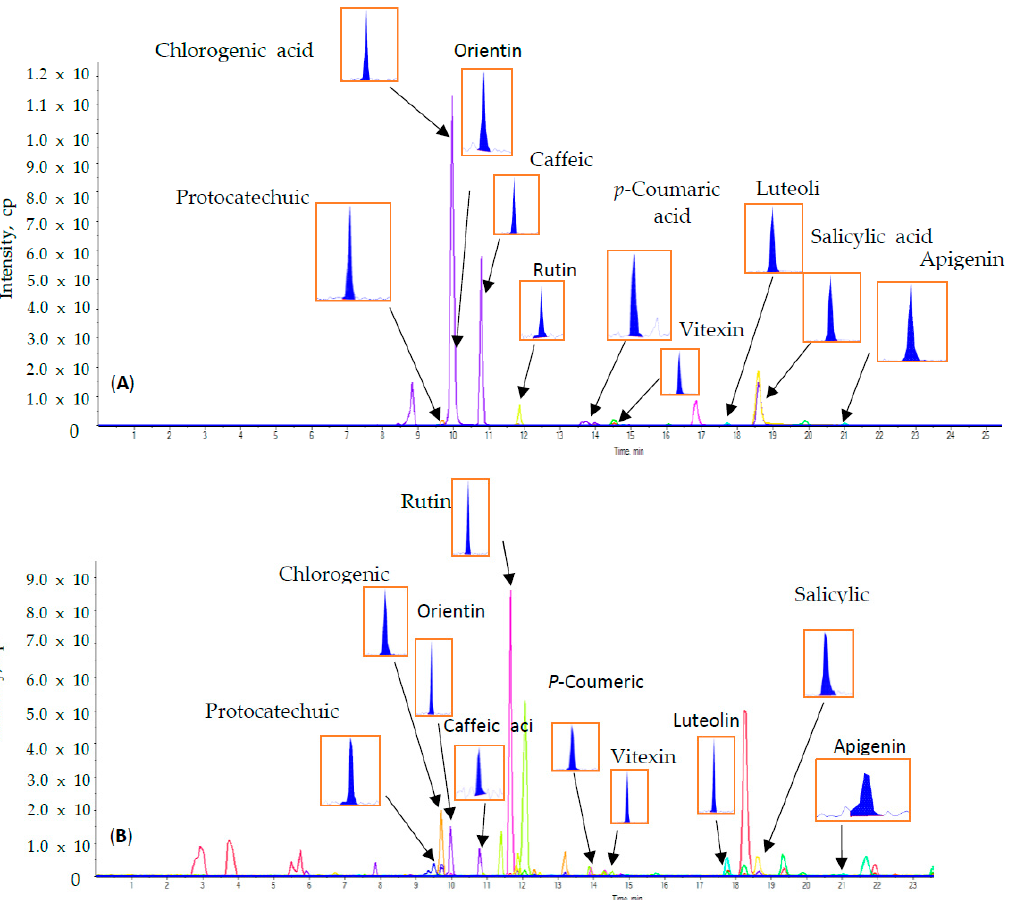
Figure 2. Representative MRM ion chromatogram of phenolic compounds from A. japonica root extracts harvested in the month of ( A ) October, ( B ) November. Extract ion chromatograms of individual phenolic metabolites with small peaks are given in rectangular boxes with their retention time.